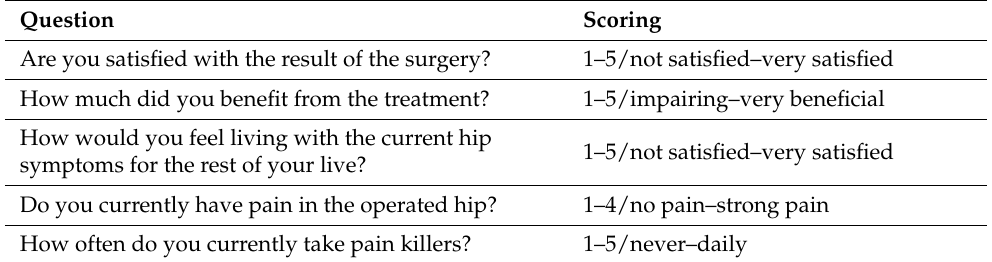
Table 1. Questions supplementing the PRO scores regarding patient satisfaction and pain.